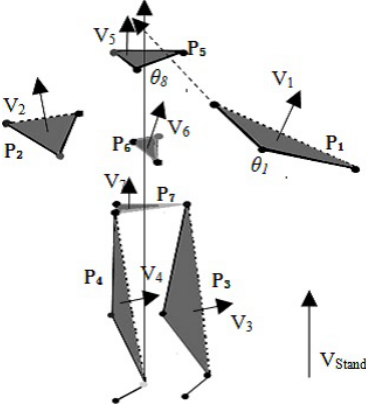
Fig. 8 Plan view of human bone